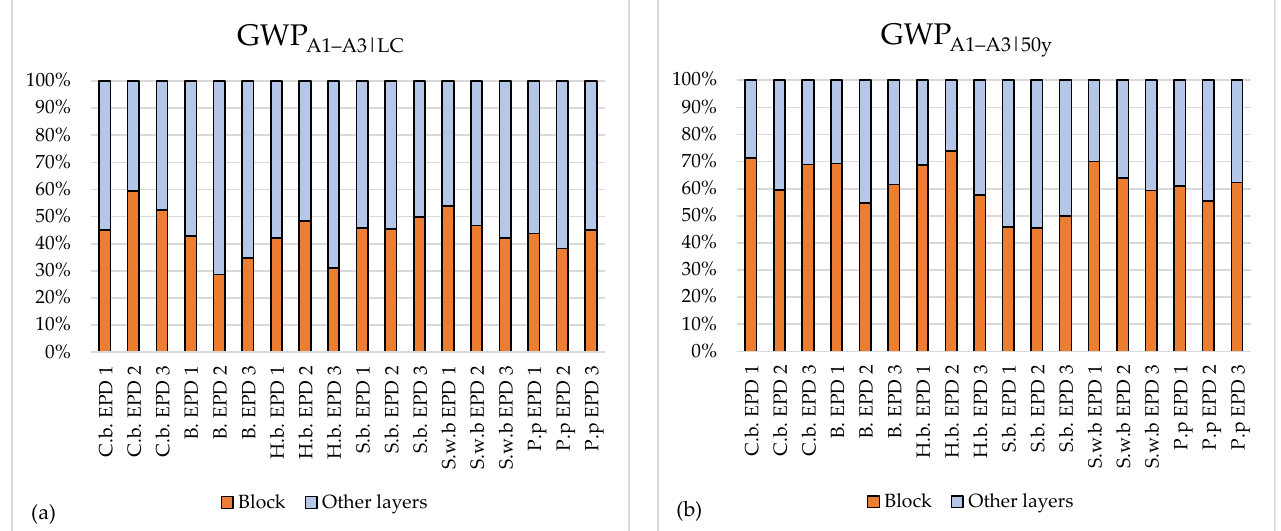
Figure 10. ( a ) GWP A1–A3|LC and ( b ) GWP A1–A3|50y : contribution of construction blocks and other layers to the total. (C.b. = Concrete block; B. = Bricks; H.b. = Hollow bricks; S.b. = Sandstone bricks; S.w.b. = Shuttering wood chips blocks; P.p = Prefabricate concrete panels.